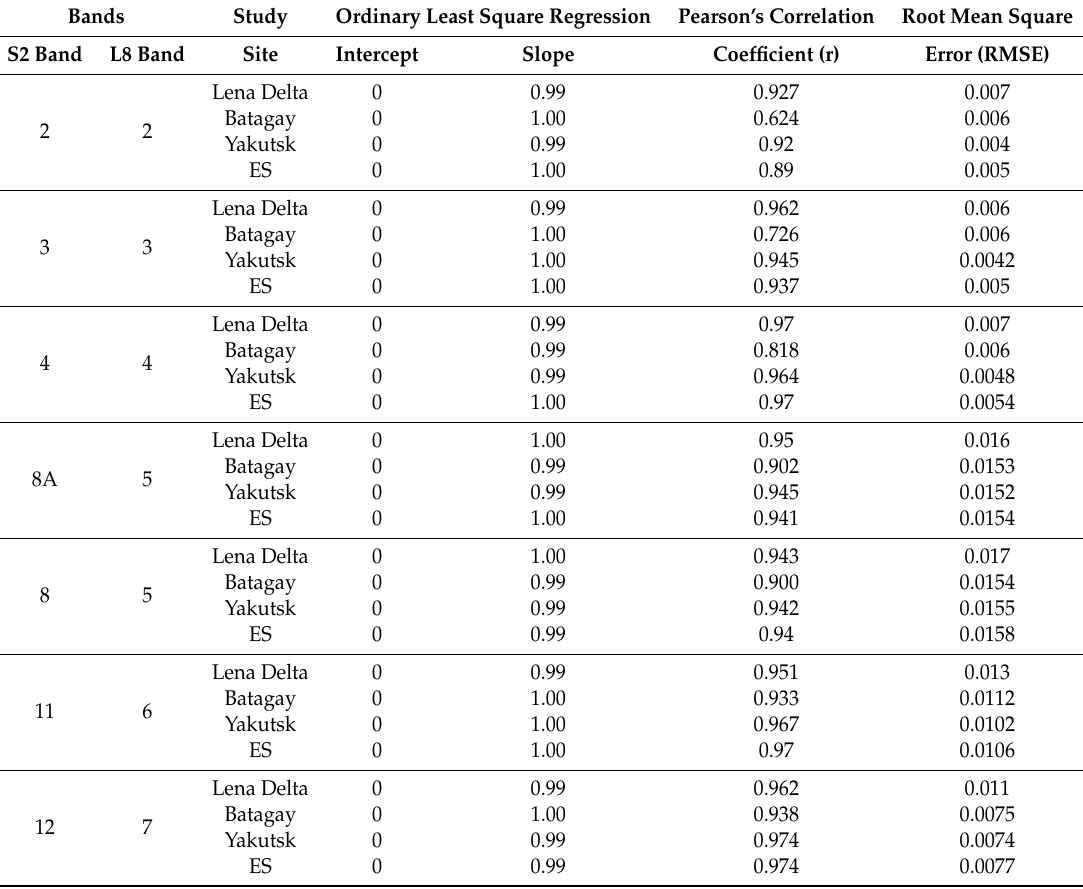
Table 4. Comparison of surface reflectance values from the Sentinel-2 and Landsat-8 corresponding bands after spectral band adjustment, for same-day acquisitions. Displaying the results of the ordinary least squares regression, Pearson correlation, and root mean squared error for every study site. Bands Study Ordinary Least Square Regression Pearson’s Correlation Root Mean